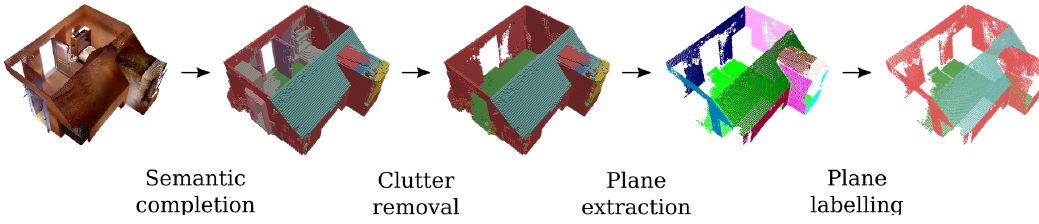
Figure 9. Overview of the semantic extraction